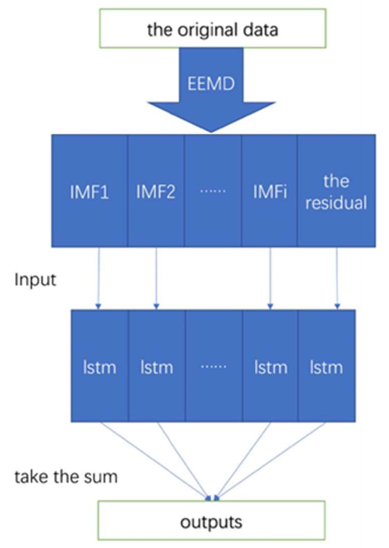
Figure 2. Flowchart of the proposed EEMD-LSTM hybrid model.